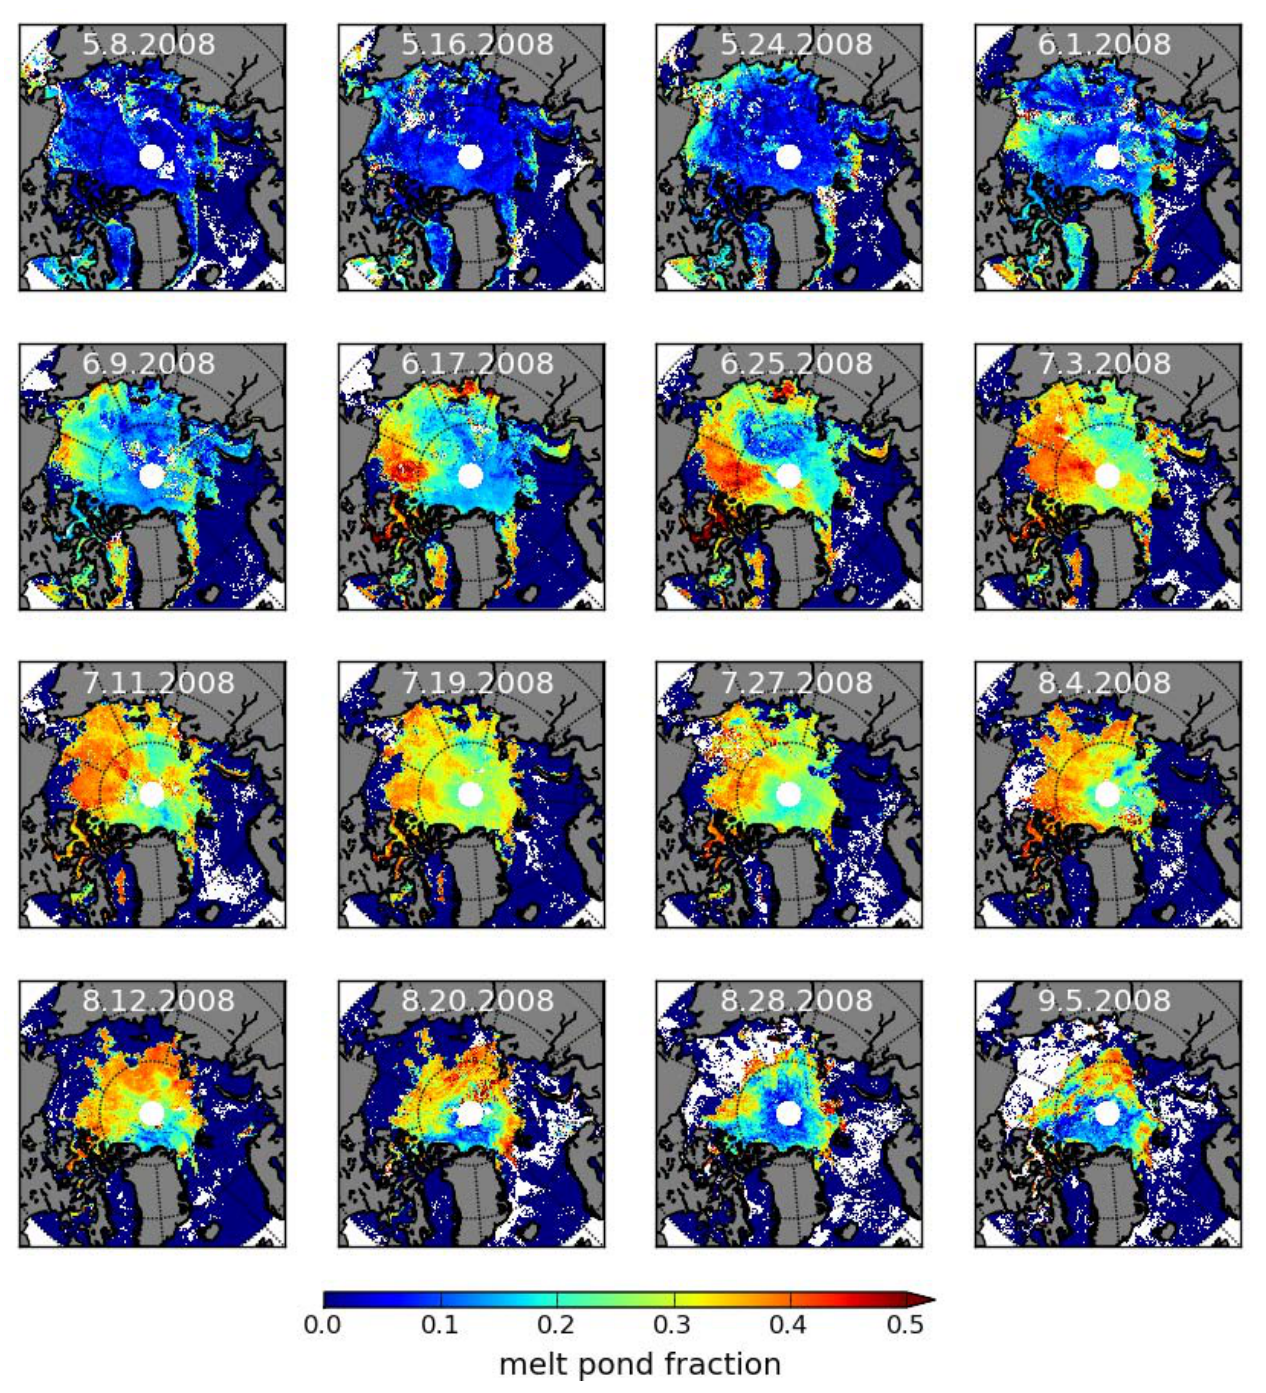
Fig. 4. Seasonal cycle of the relative melt pond fraction from MODIS satellite data for the Arctic for the example of the 2008 melt season. White pixels represent missing